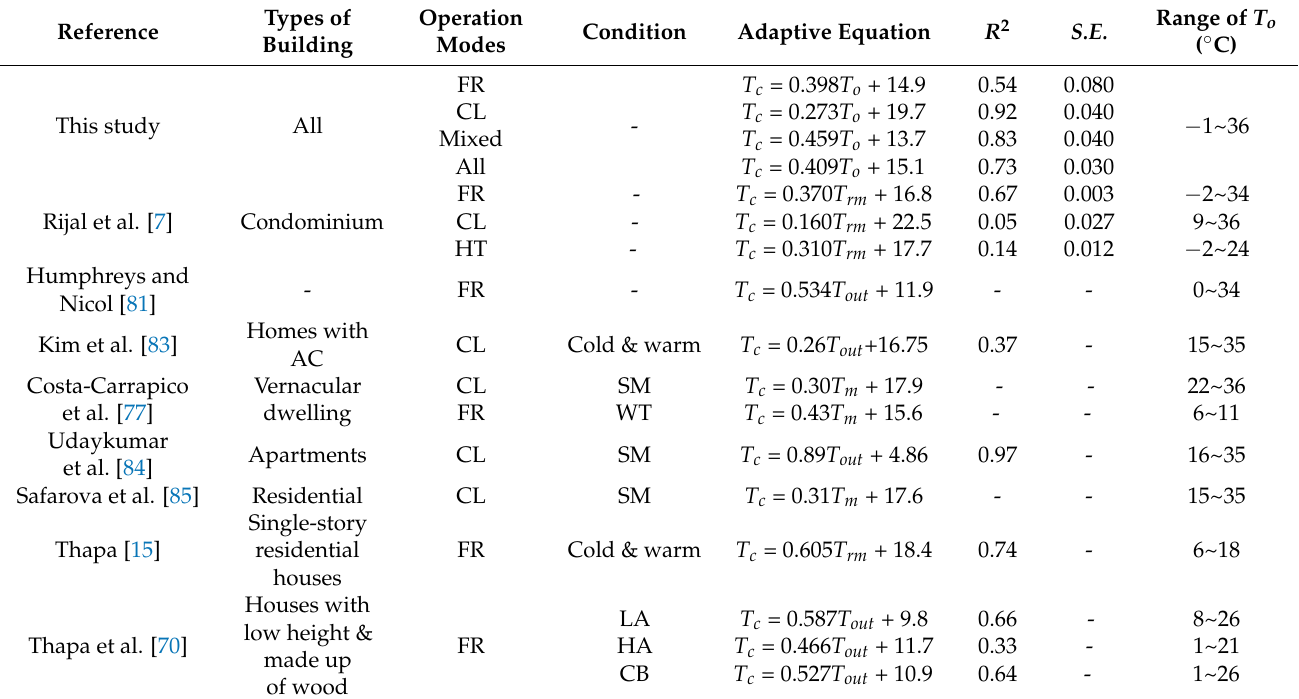
Table 4. Adaptive thermal comfort equation from previous